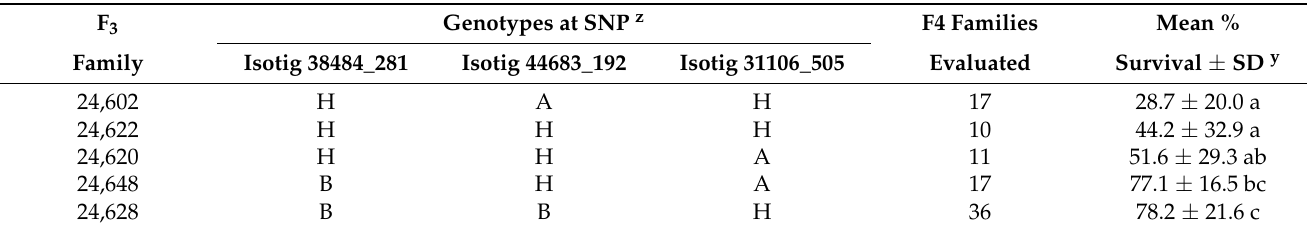
Table 4. Genotypes at single-nucleotide polymorphisms (SNPs) segregating with the highest significance for resistance to Fusarium basal rot (FBR) in F 3 families of onion, numbers of F 4 families derived from each F 3 family, and mean percentage (%) survival ± standard deviations (SD) of the F 4 families determined using a seedling evaluation for FBR.